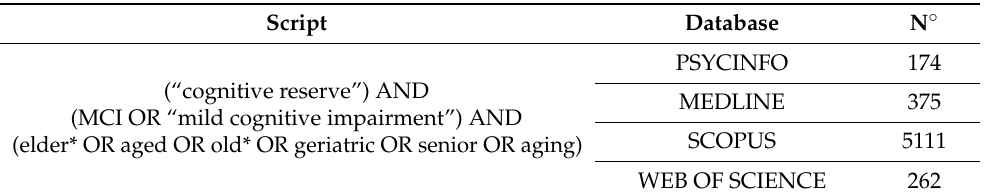
Table 1. Databases and